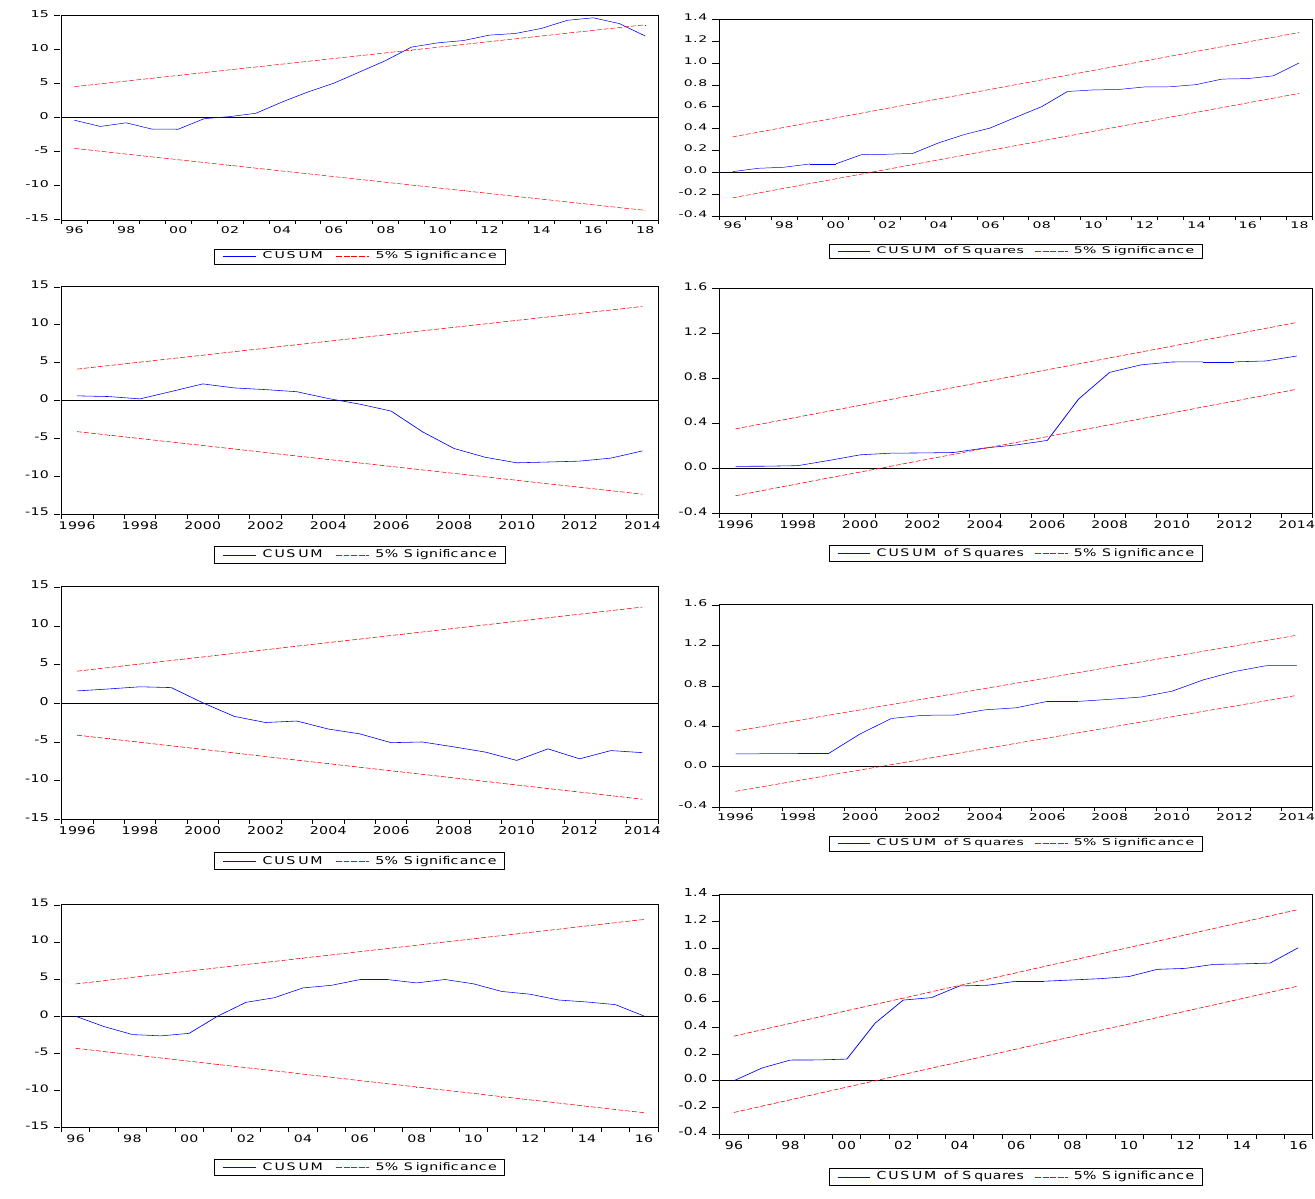
Figure 1. A plot of CUSUM, which is based on the cumulative sum of recursive residuals, and CUSUMQ, which is based on the cumulative sum of squared recursive residuals.